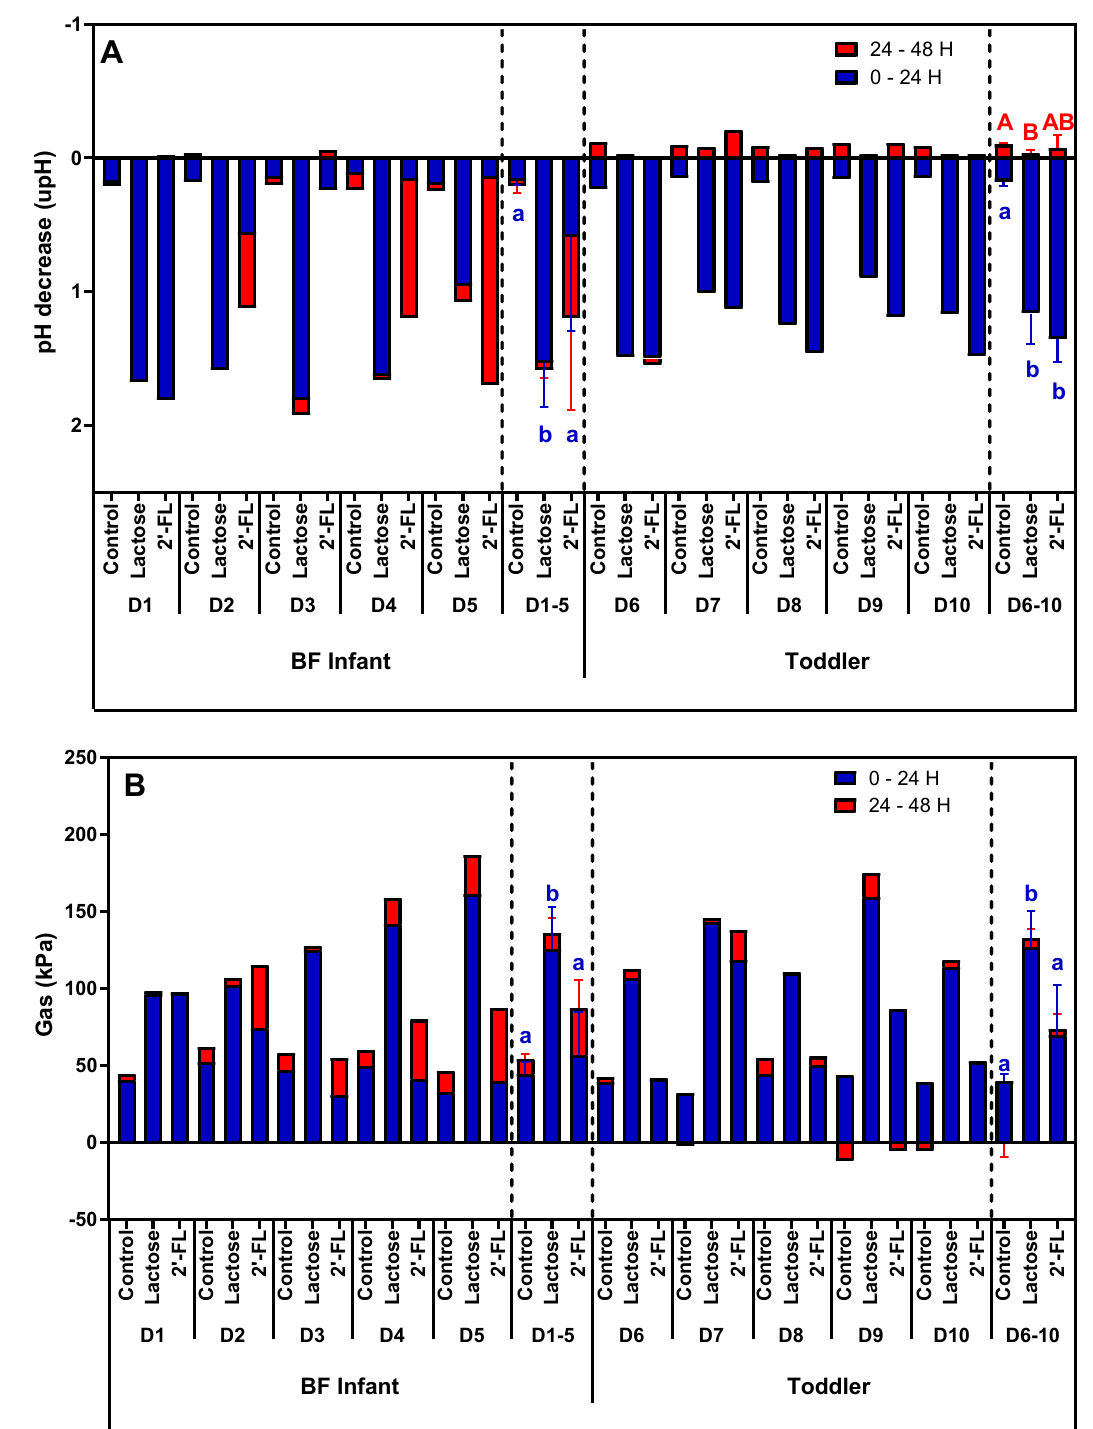
Figure 2. Effect of lactose or 2’-FL on fermentation parameters in short-term colonic incubations. Bars represent changes in ( A ) pH and ( B ) gas formation during two time intervals (0–24 h and 24–48 h) of 48 h fecal batch incubations for five BF infants (D1, D2, D3, D4, and D5) and five toddlers (D6, D7, D8, D9, and D10), upon treatment with lactose or 2’-FL versus a blank control. Besides presenting the data for each donor separately, the average and standard deviation within age group is also presented (D1–5; D6–10). BF = breastfed; 2’-FL = 2’fucosyllactose; D = donor. Significant differences between the average control and the two treatments per age group, as tested with a two-way ANOVA with Bonferroni correction, are indicated with different letters (0-24 h: a, b; 24-48 h: A, B; p